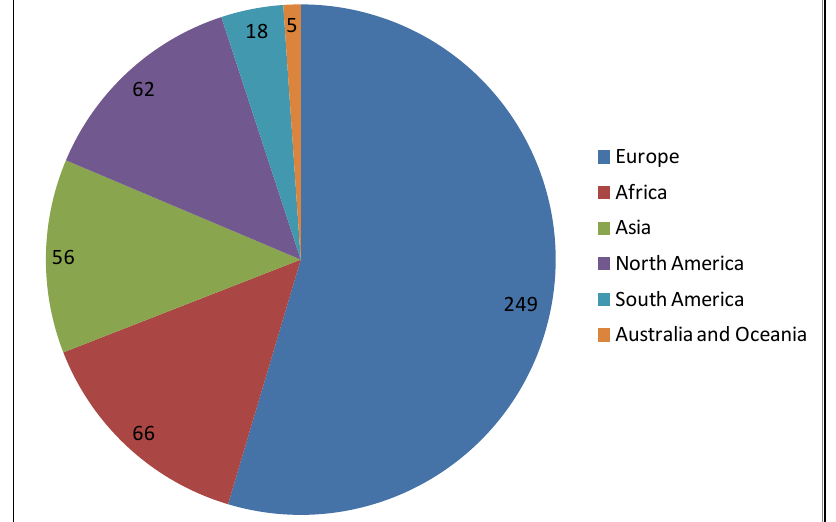
Figure 1. Distribution of ICTeSSH 2020 participants per